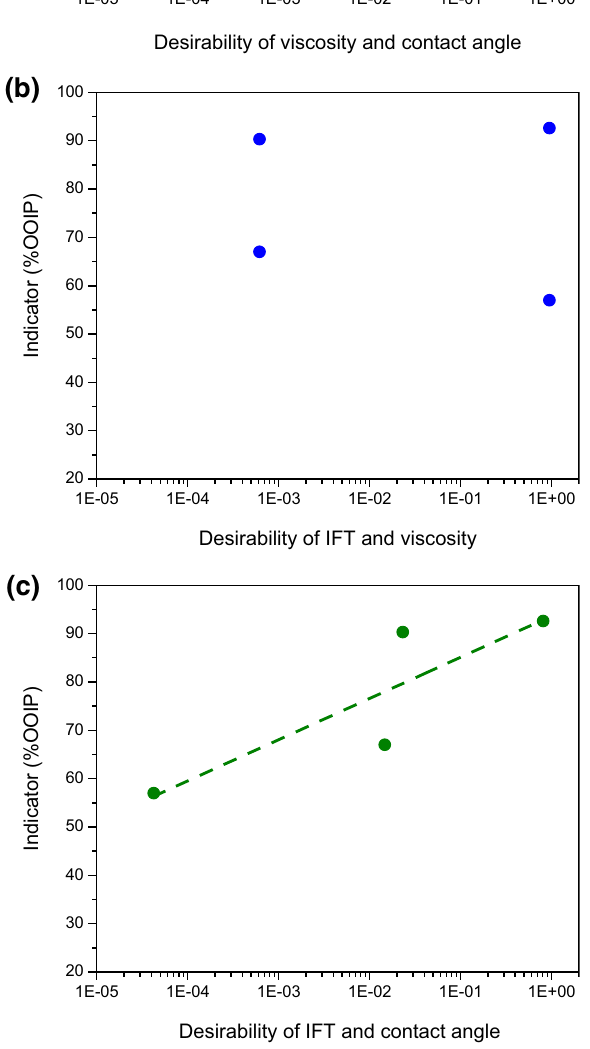
Fig. 4 Duo-desirability (combined from only two affecting factors) to the oil recovery (%OOIP) as an assessing indicator: a without inter- facial tension, b without contact angle and c without viscosity. The lines in a and c are linearly fitted with the same R 2 =